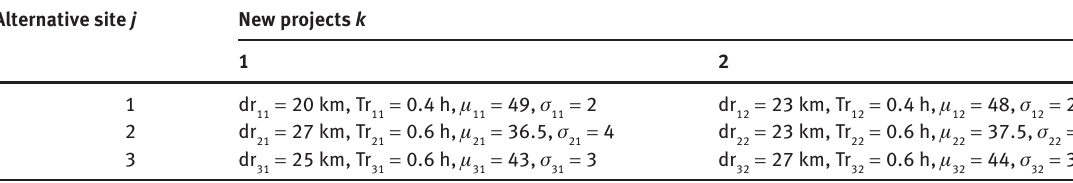
Table 2. Relevant Data of Alternative Sites and New Projects.